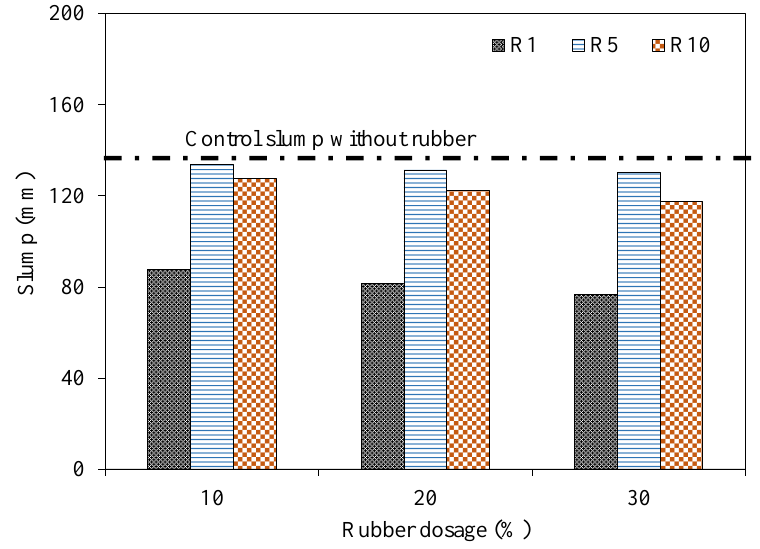
Figure 7. Slump flow for the mixture incorporating various dosages of rubber.